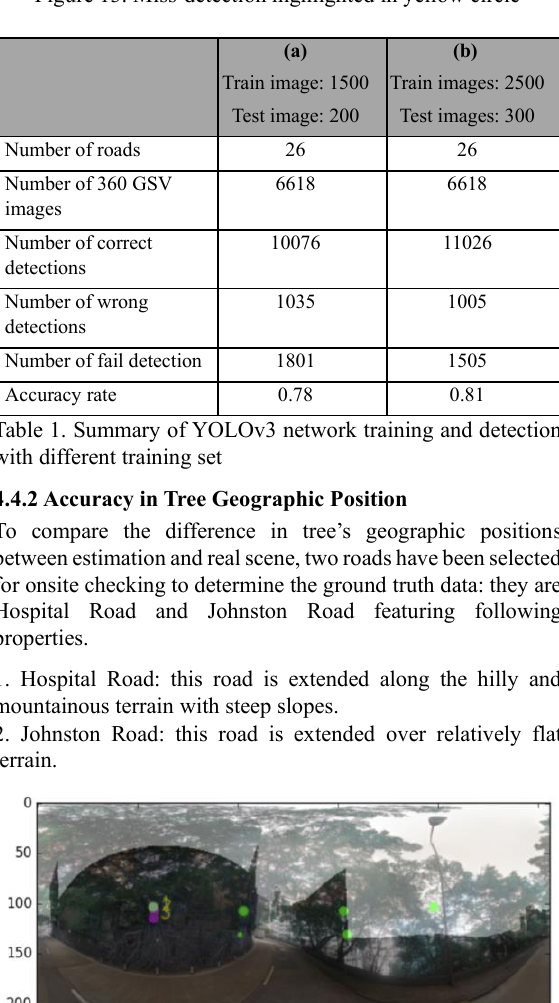
Figure 13. Miss-detection highlighted in yellow circle